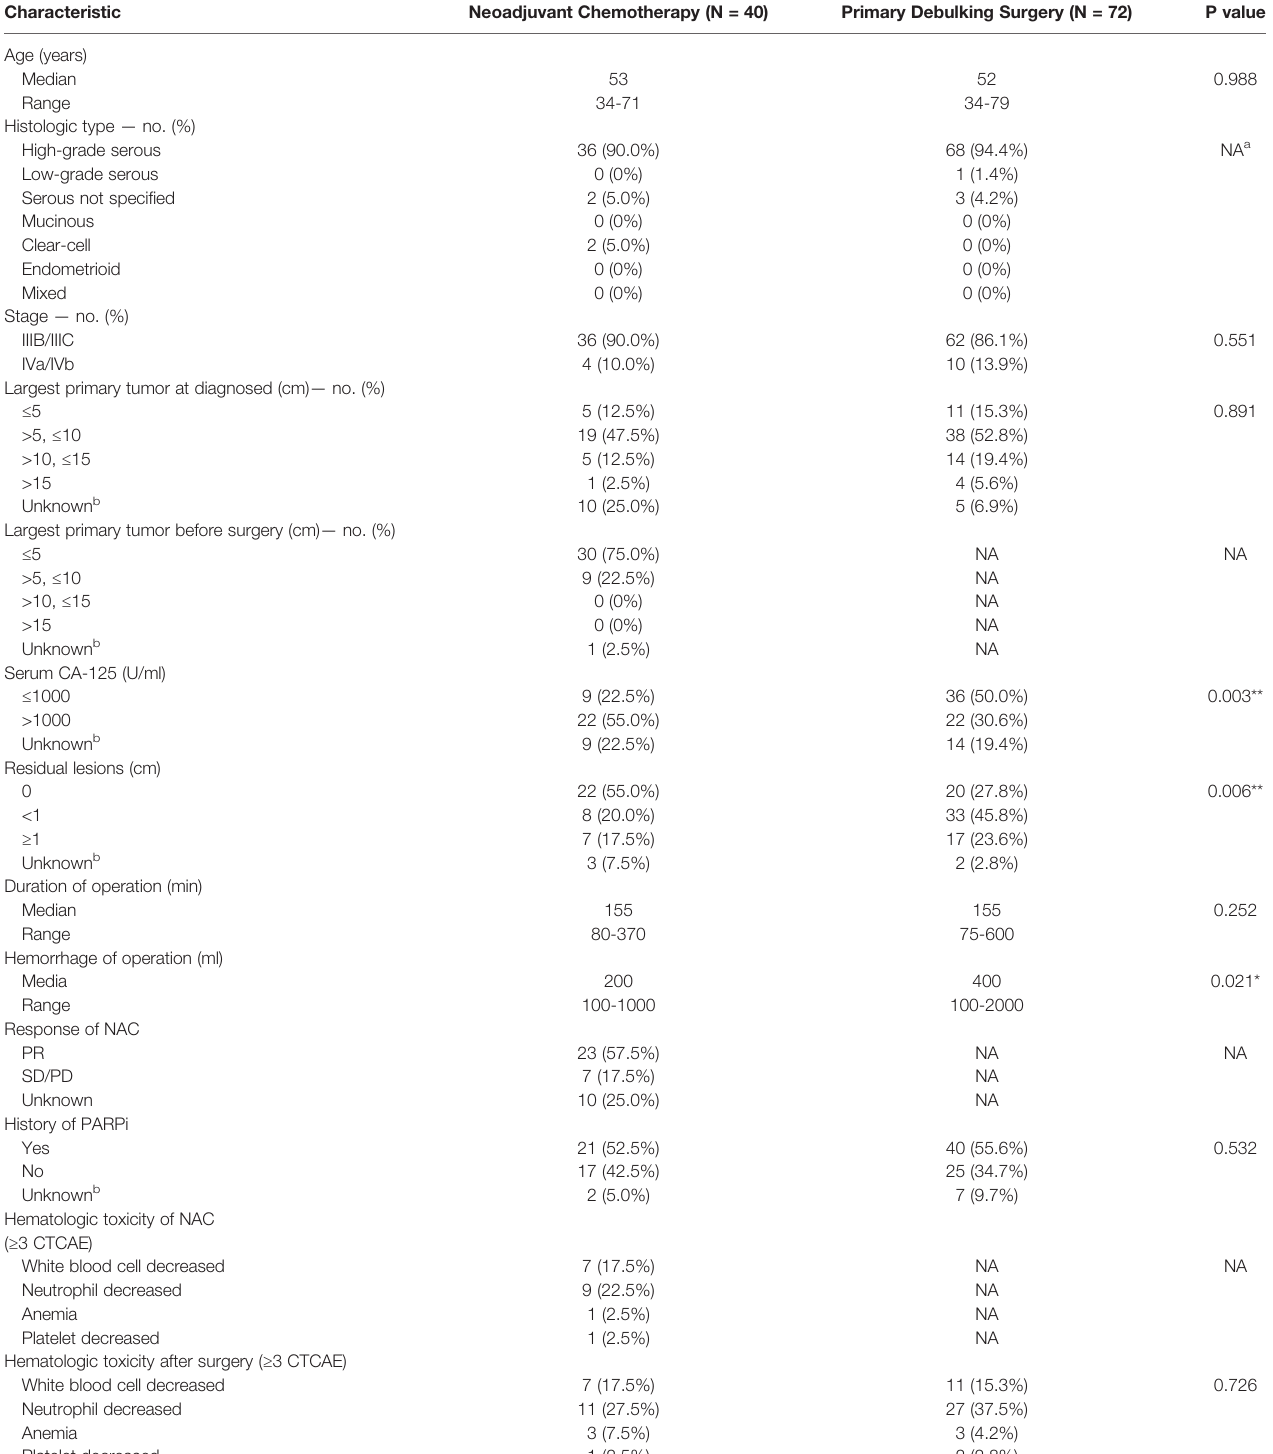
TABLE 3 | Baseline characteristics of the BRCAmut